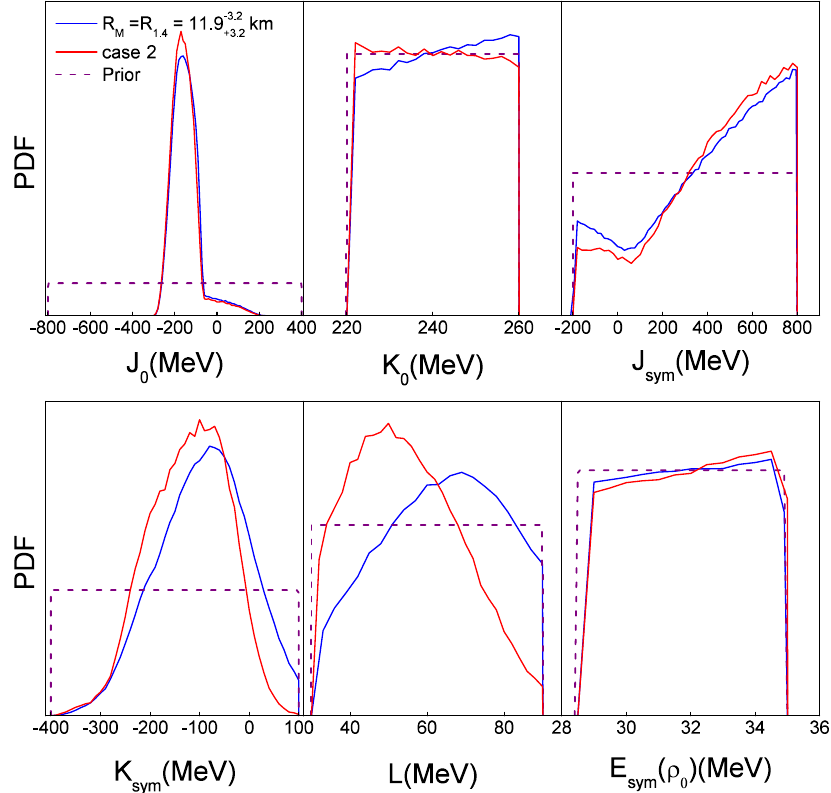
Figure 13. Prior and posterior probability distribution functions of EOS parameters assuming all neutron stars have the same radius of R M = R 1.4 = 11.9 ± 3.2 km in comparison with the results from Case 2, which has the same mean radius of 11.9 km, but an error bar of 1.4 km at a 90% confidence level (black curves shown in Figure 10). Taken from